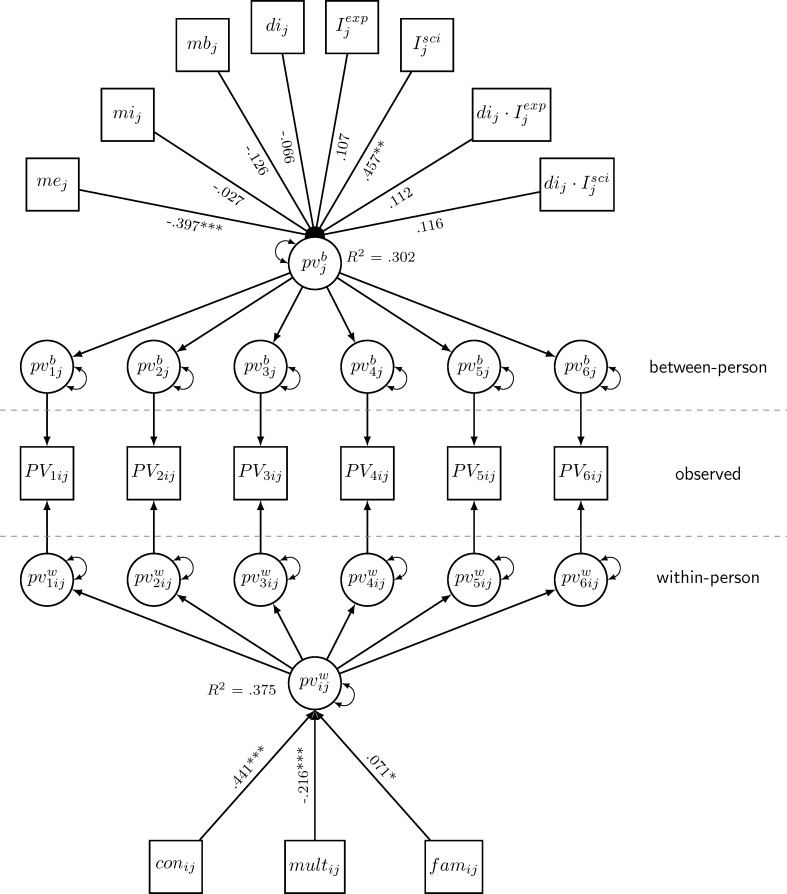
Standardized effects of confounders, topic-specific multiplism and the FREE (M5).Note: χ2 = 148.954, df = 74, CFI = 0.967, TLI = 0.957, RMSEA = 0.027, SRMRwithin = 0.026, SRMRbetween = 0.043, con = topic-specific consistency; di = d-index (FREE); Iexp = dummy variable contrasting the ‘expert statement’ with the ‘practitioner statement’ group; Isci = dummy variable contrasting the ‘scientific study’ with the ‘practitioner statement’ group; fam = topic familiarity; mb = benevolence (METI); me = expertise (METI); mi = integrity (METI); mult = topic-specific multiplism; pv = perceived value of GPK for practice. *p < .05, **p < .01, ***p < .001.